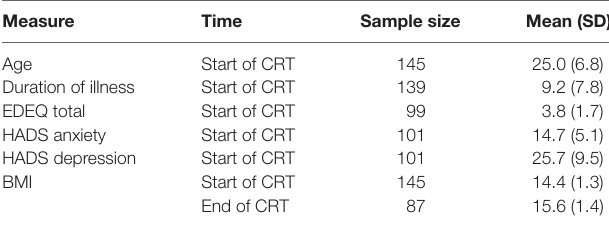
TaBle 1 | Participant